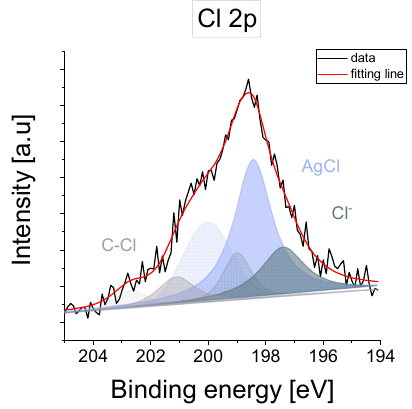
Figure 6. The XPS spectra of ( a ) Ag 3d, ( b ) Si 2p, ( c ) O 1s, and ( d ) the C 1s core levels with the fitting result. The individual colors on the specific lines' core levels refer to the individual chemical surroundings linked to the silver, silica, oxygen, and carbon.